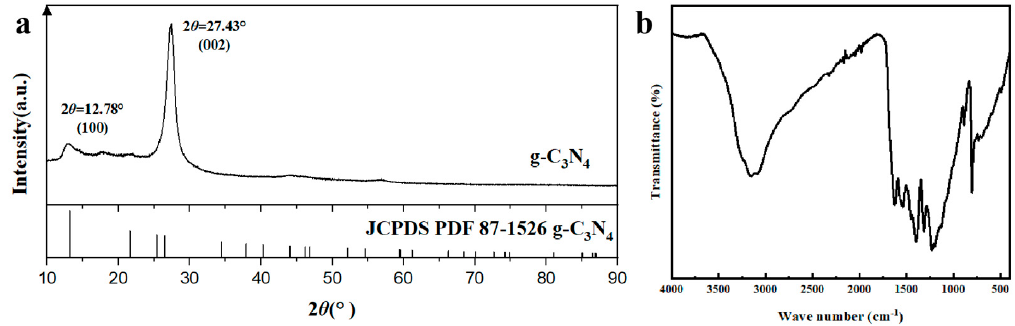
Figure 4. ( a ) XRD and ( b ) FT − IR profiles of the g − C 3 N 4 nanosheets.